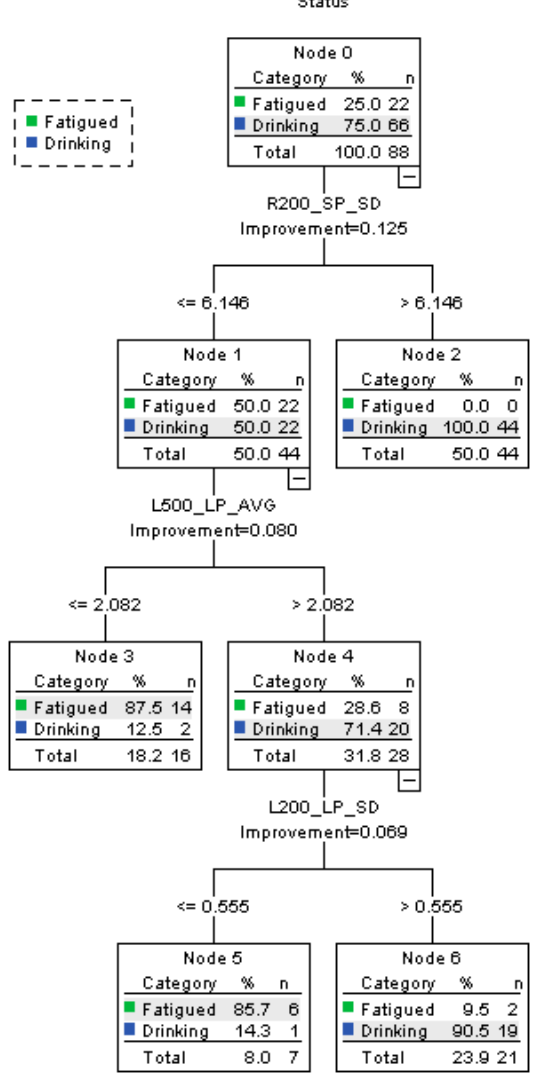
Figure 6. Decision tree diagram for the CART model of fatigued vs. drunk driving.